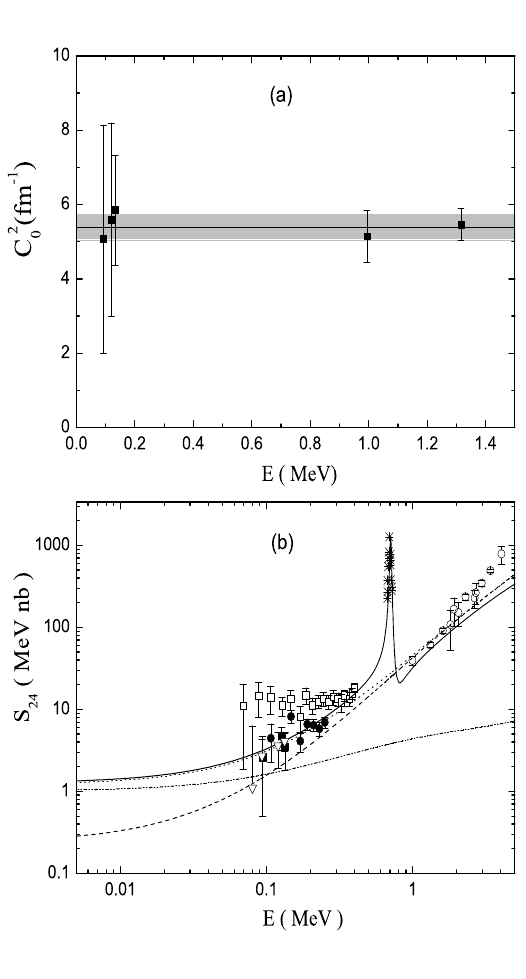
Figure 1. The square of the ANC (( C exp ) 2 ) for α + d → 6 Li obtained in the present work at the 0 experimental energies E above ( a ), their weighted mean (the solid line) and its uncertainty (the width of the band) as well as the experimental and calculated astrophysical S factors ( b ) for the d ( α, γ ) 6 Li reaction. The caption of ( b ) is given in detail in the